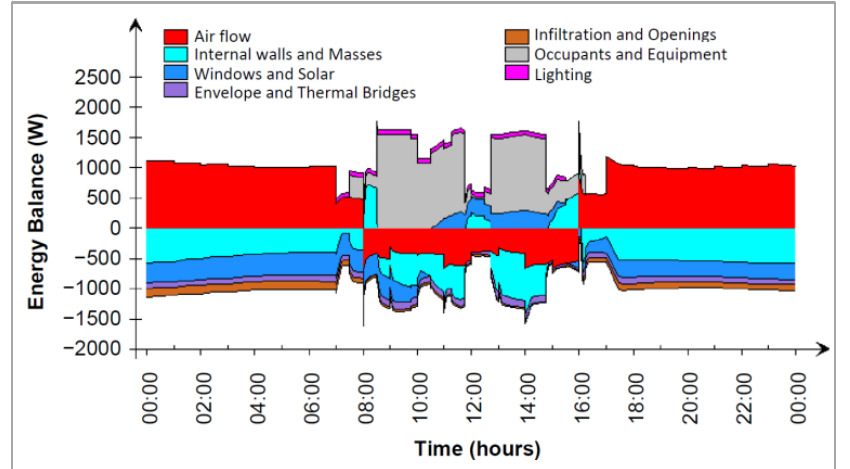
air to the classroom was supplied at fairly low temperatures in order to represent a worst- case scenario.